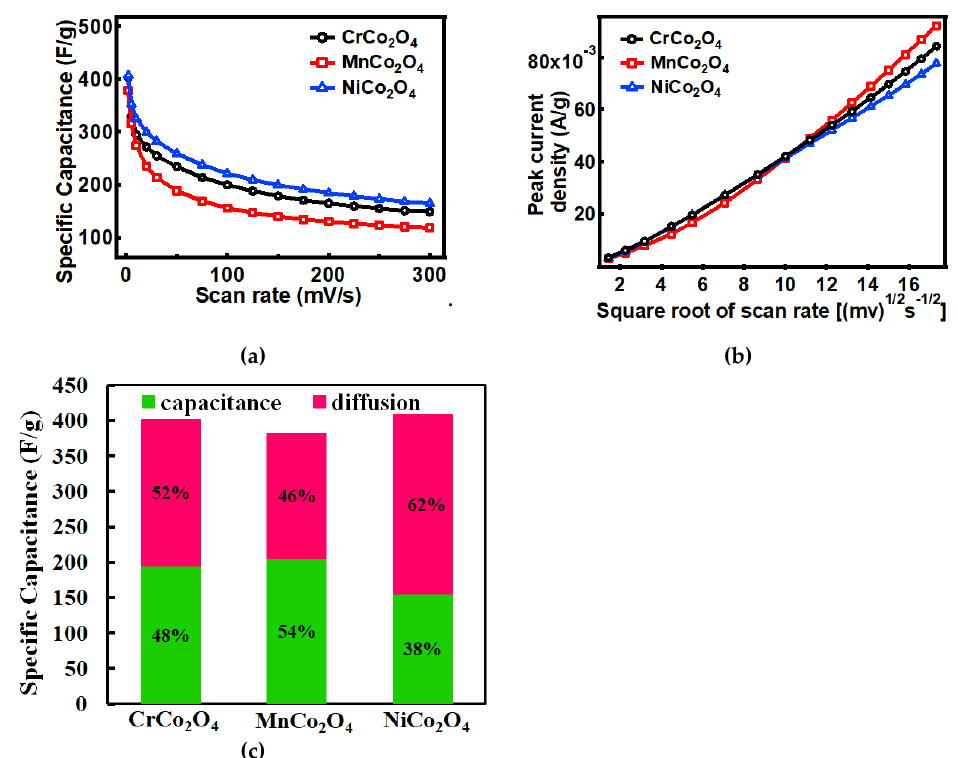
Figure 5. ( a ) Specific capacitance vs. scan rate, ( b ) and peak current vs. (scan rate) 1/2 , and ( c ) diffusion and capacitive contribution to the specific capacitance.